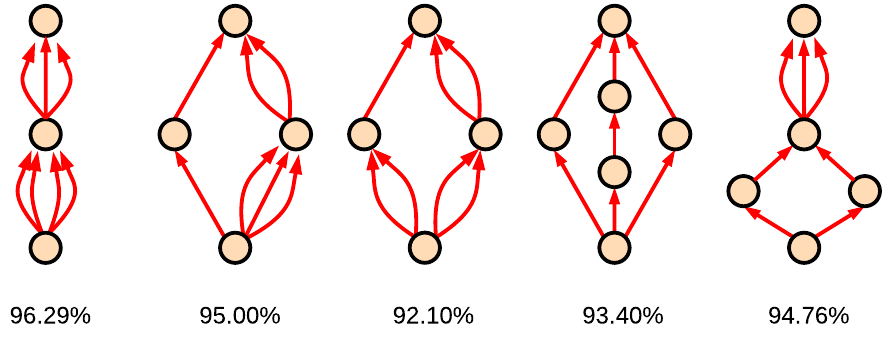
Figure 11. Some of the non-classical array-digraphs of 7 panels that perform over the 90% maximum power